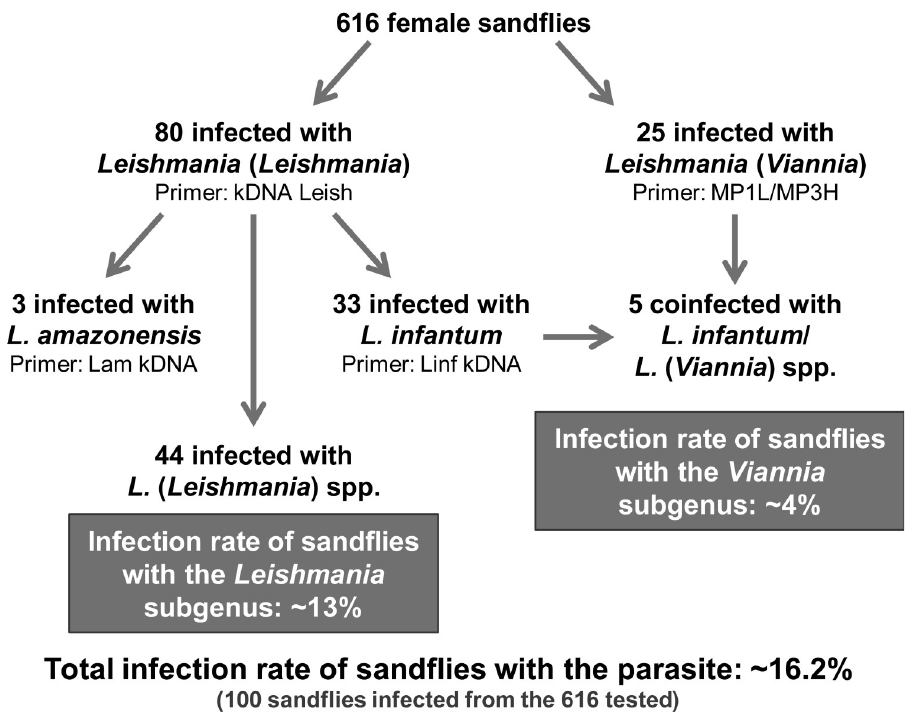
Fig 6. Overview of the results obtained in the study of the Lu . longipalpis infection with Leishmania . The number of infected sand flies and the total and subgenus infection rate are shown in the diagram.